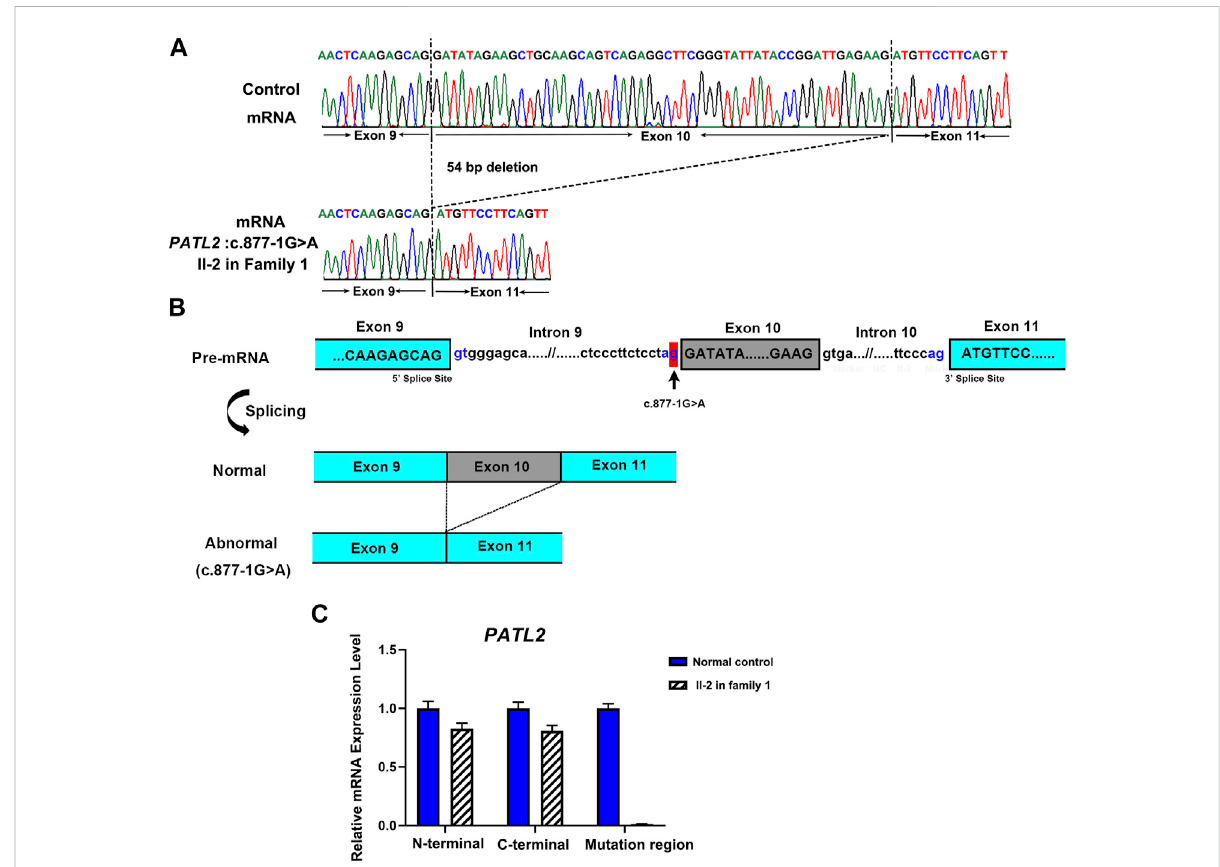
FIGURE 3 Functionalanalysisoftheidenti fi ednovel PATL2 splicesitevariant. (A) SangersequencingtracesoftheRT – PCRproductsshowedthewild-type (normal control, top) and PATL2 exon 10 skipped transcripts (II-2 in the family, bottom). (B) Schematic representation of exon 9 to exon 11 of PATL2 showing normal or abnormal splicing. The boxed regions denote exons, whereas the connecting lines indicate introns. (C) Quantitative RT – PCR (qRT – PCR) of the relative PATL2 mRNA expression in peripheral blood lymphocytes from the affected individual (II-2) and the normal female controls(NC).ForallqRT – PCRassays,glyceraldehyde3-phosphatedehydrogenase( GAPDH )wasusedasanendogenouscontrol.NCwassetto1.0, and data are presented as the mean ± SD ( n ≥